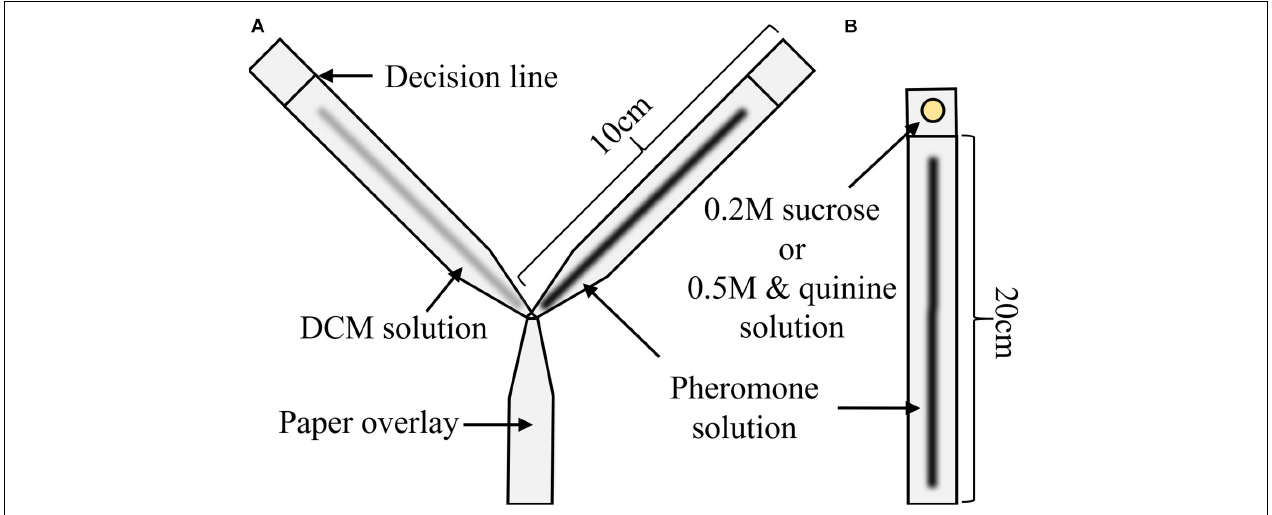
FIGURE 1 | Setups used during the experiments. (A) To assess pheromone attraction, ants had to decide between a 10 cm × 1 cm arm treated with DCM (here left, gray) or pheromone (here right, black). When ants reached the decision line, their decision was scored and they were there removed from the maze. (B) In experiments 1 and 2, ants crossed a runway treated either with pheromone (shown in black) or DCM (not shown) to reach a sucrose syrup drop at the end of a 20 cm × 1 cm long runway. In experiment 3, the setup was identical, but instead of a 0.2 M sucrose syrup, 0.5 M sucrose containing either 58.6 or 78.1 µ M quinine was presented. Please note that the applied pheromone solutions were invisible once applied and are colored here for illustration purposes.